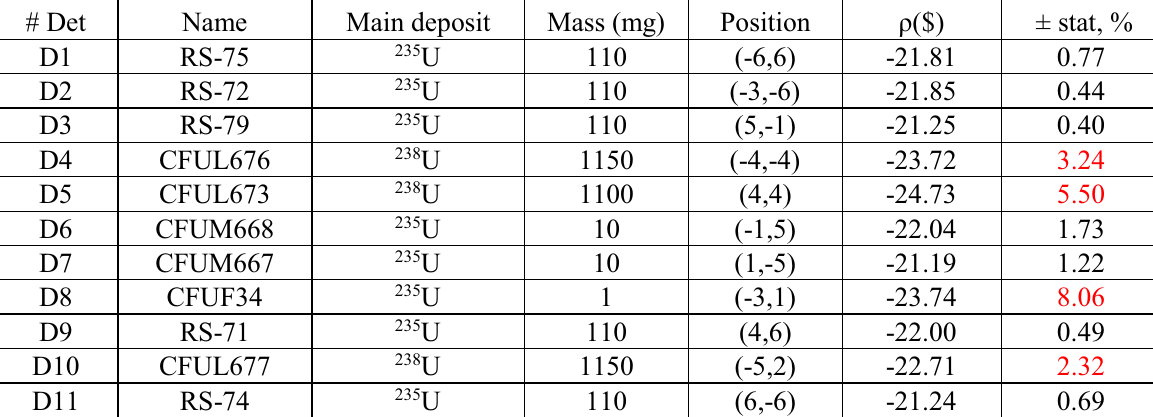
Table II. Reactivity values obtained in SC10/4 core with detector Setup